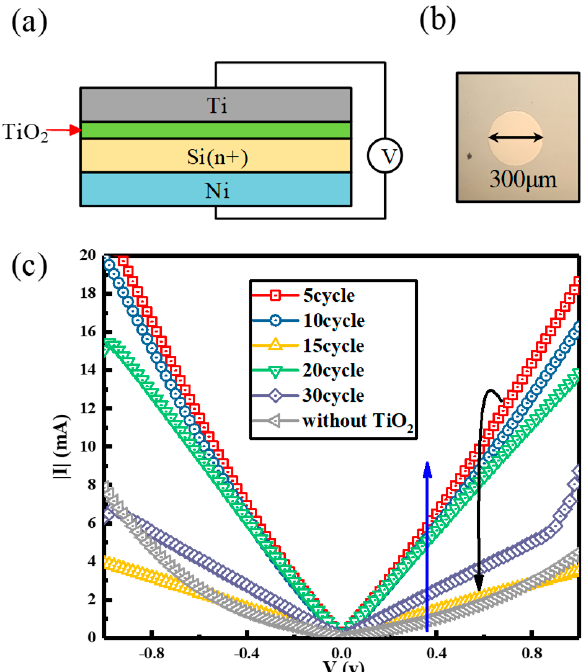
Figure 2. ( a ) Schematic cross-sectional view of the Ti/insertion layer (IL)/n-Si metal-insulator- semiconductor (MIS) structures with different ALD cycles. ( b ) A high magnification optical images of the MIS structure whose Ti pad diameter is 300 µ m. ( c ) The I–V characteristics of Ti/insertion layer (IL)/n-Si (doping level is ~10 19 cm − 3 ) MIS structure with different ALD cycles. Figure 3a shows the XPS results of Ti 2p of samples for 20 cycles and 300 cycles of ALD process and all the XPS results are calibrated with C 1 s peak at 284.8 eV [23,24]. The two curves have two distinct peaks at about 458–459 eV and 464–465 eV, which represent for Ti 2p3/2 and Ti 2p1/2 peaks and are consistent with typical values of TiO 2 . Figure 3b shows that O 1 s results with thin TiO 2 , shoulder left to O 1 s peak is obvious. This shoulder located at 531.5 eV represents for oxygen vacancies and it indicates that thin sample has more oxygen vacancies. The illustration in the upper left corner shows the fitting curve of 300 cycles. It can be seen that the peak of oxygen vacancies is not obvious. In conclusion, there are some oxygen vacancies in thin TiO 2 film, which will dope TiO 2 and make it more conductive [24]. Due to the presence of a donor band related to oxygen vacancies which can provide more electrons, TiO 2 behaves as an n-type semiconductor and exhibits good electrical